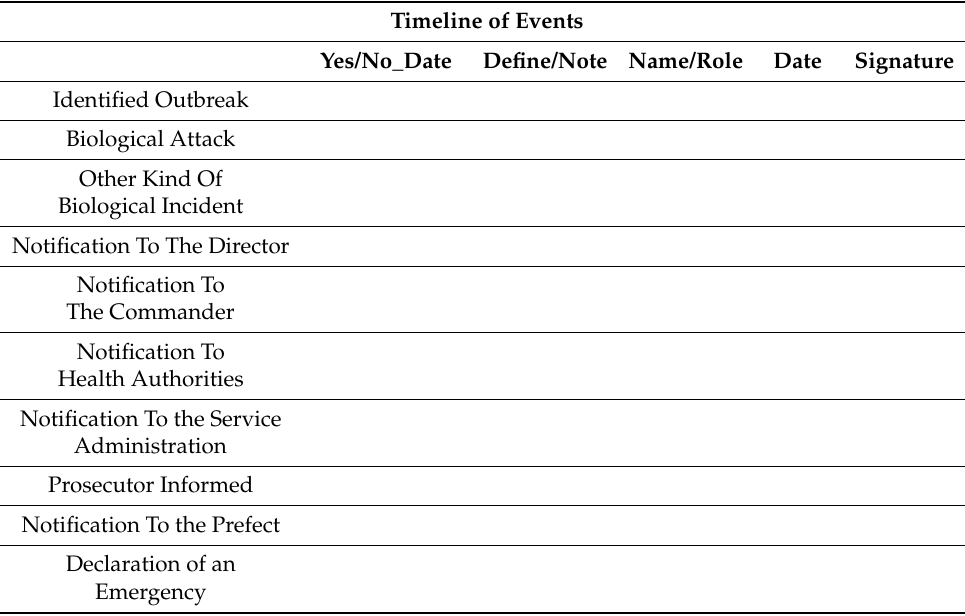
Table 4. A checklist to record the timeline of each single step during the